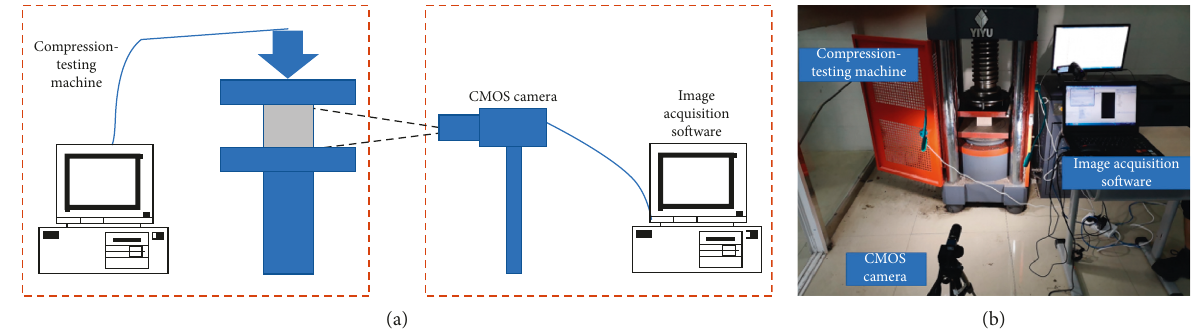
Figure 2: Schematic representation (a) and experimental setup (b) of the of image acquisition